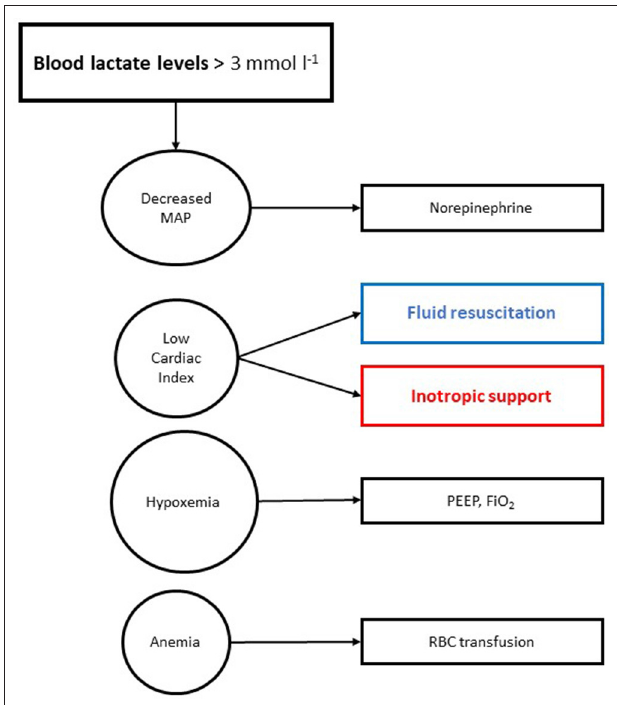
FIGURE 2 | Usual hemodynamic algorithm. MAP, mean arterial pressure; PEEP, positive end-expiratory pressure; FiO 2 , fraction of inspired oxygen; RBC, red blood